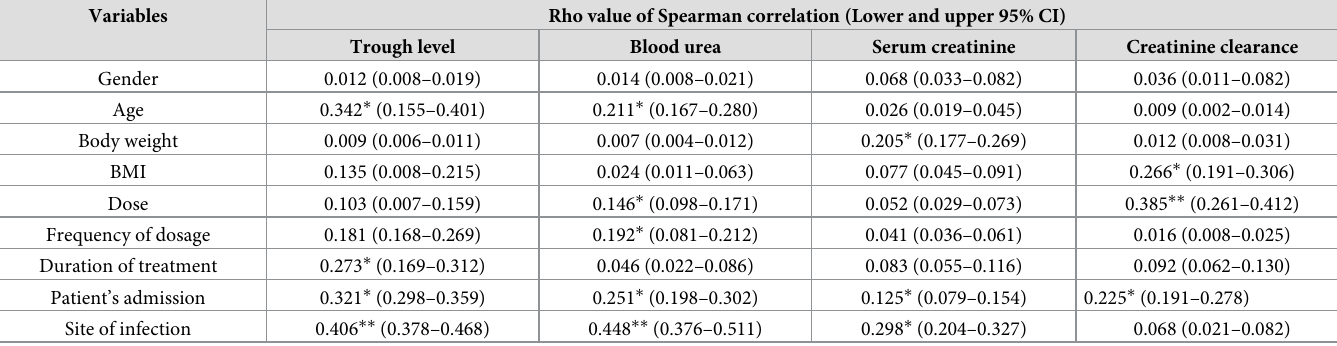
Table 5. Correlation summary between the variables and renal functions after treatment with vancomycin.